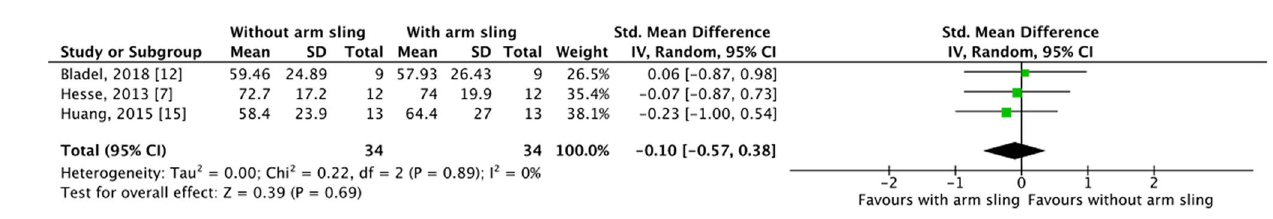
Figure 6. Forest plot for cadence